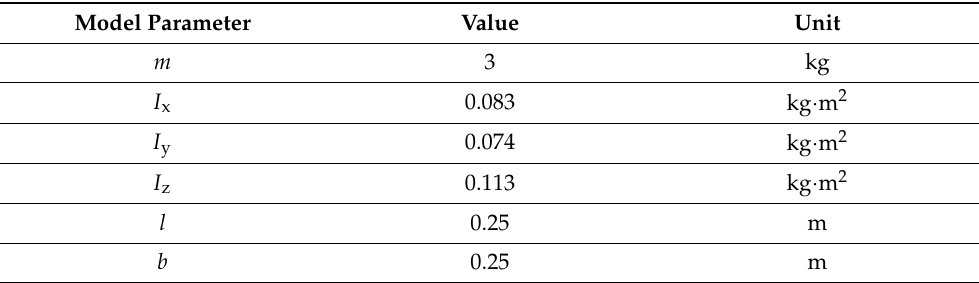
Table 4. The main parameters of the robot.